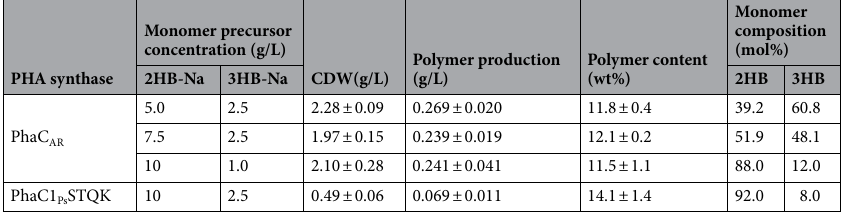
Table 1. Synthesis of P(2HB- b -3HB) and P(2HB- ran -3HB) in E. coli. Data are the mean ± standard deviation of three independent tests. CDW cell dry weight.